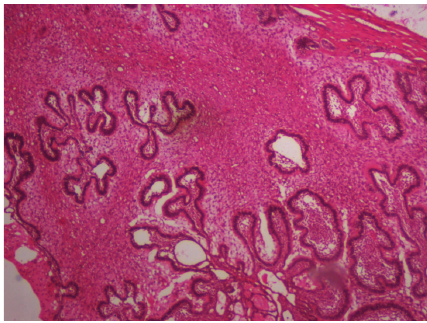
Figure 5: Photomicrograph showing ameloblastic islands in a cellular connective tissue stroma.